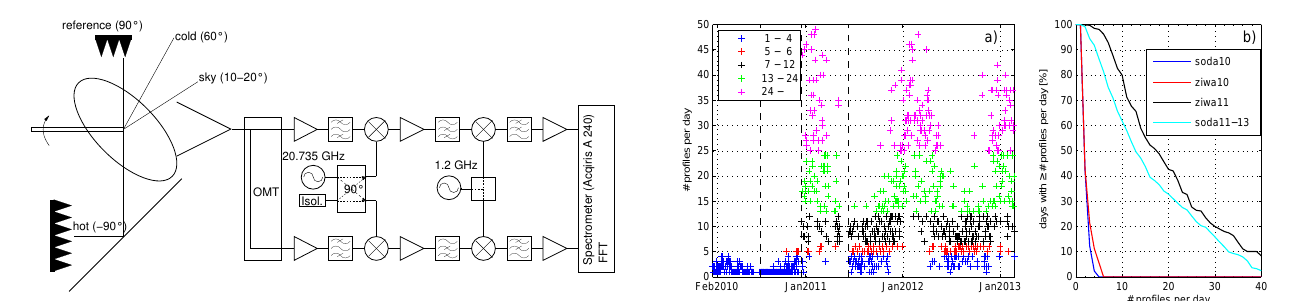
Fig. 2. Left: number of profiles obtained per day for the whole data set used for the validation study with a noise level of 0.014K from MIAWARA-C. The increase in December 2010 is due to the re- placement of the correlation receiver by the dual-polarisation re- ceiver. The black dashed vertical lines indicate the beginning of a new comparison period. Right: percentage of days with ≥ # profiles per